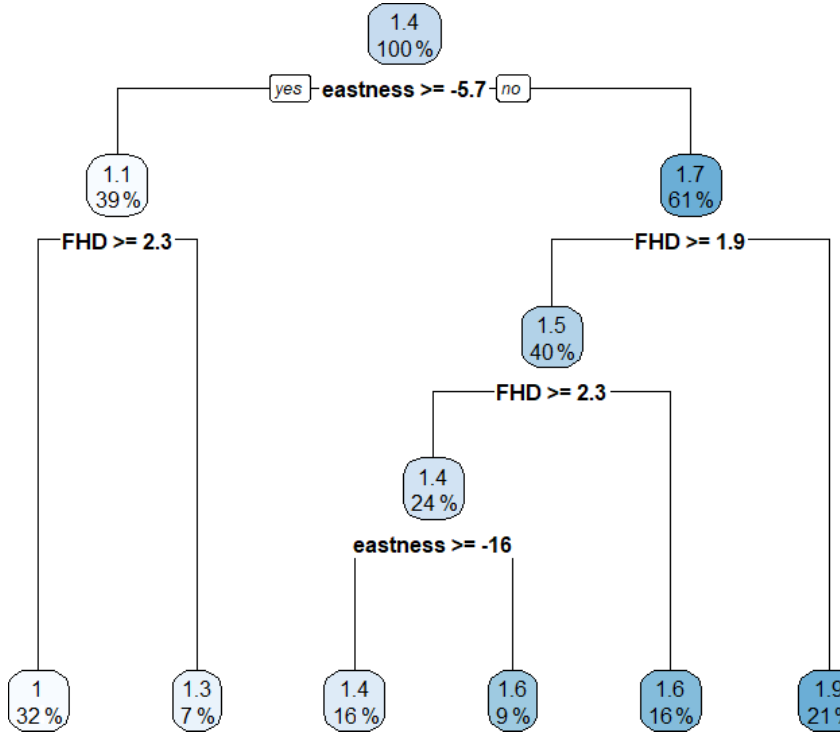
Figure 7. Decision tree at site O. Snow depths (m) are represented along with percent of the individual trees used for analysis.